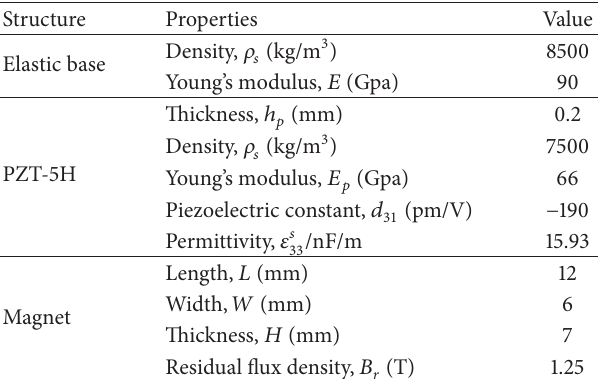
Table 1: Geometric and material properties of the nonlinear piezoelectric